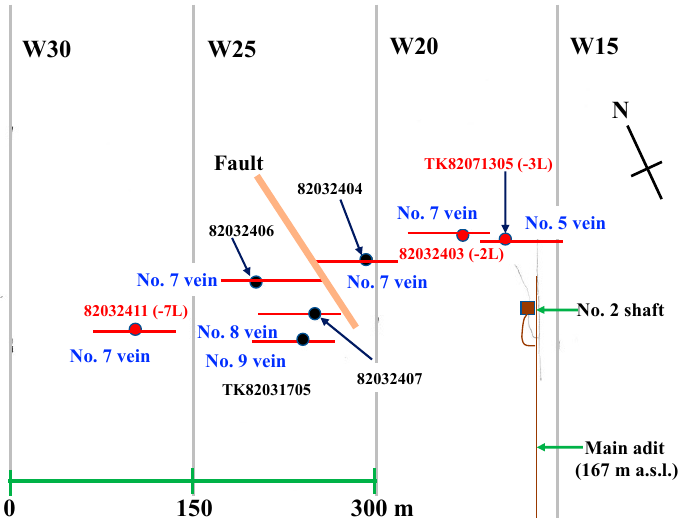
Figure 4. Schematic plan view for veins on − 4L level (57 m above sea level) of the Takatori mine. Samples from − 4L level are represented by black circles. Samples from other levels (red circles) are superimposed on the − 4L level map. Since the veins dip south, No. 7 vein on − 2L level is located in the northernmost part. The main adit (167 m above sea level) and No. 2 shaft are also shown.